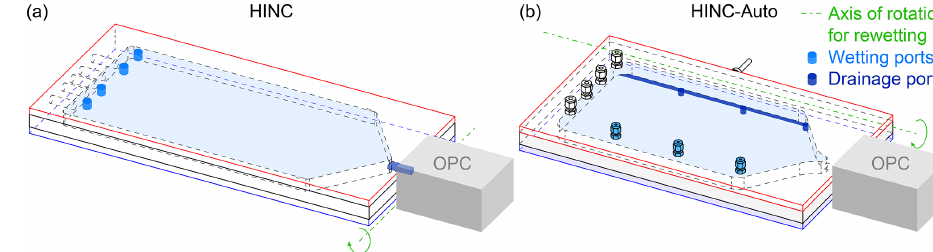
Figure 5. Illustration of the axis of rotation, location of wetting and drainage ports on (a) HINC and (b)